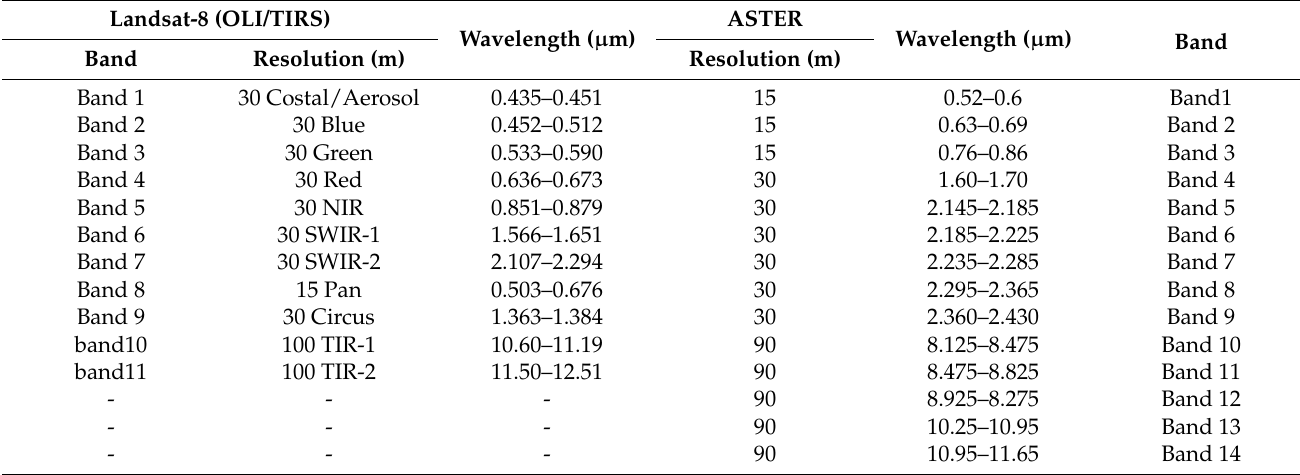
Table 1. Characteristics of the Landsat-8 OLI/TIRS and ASTER data [16,17]. Landsat-8 (OLI/TIRS)